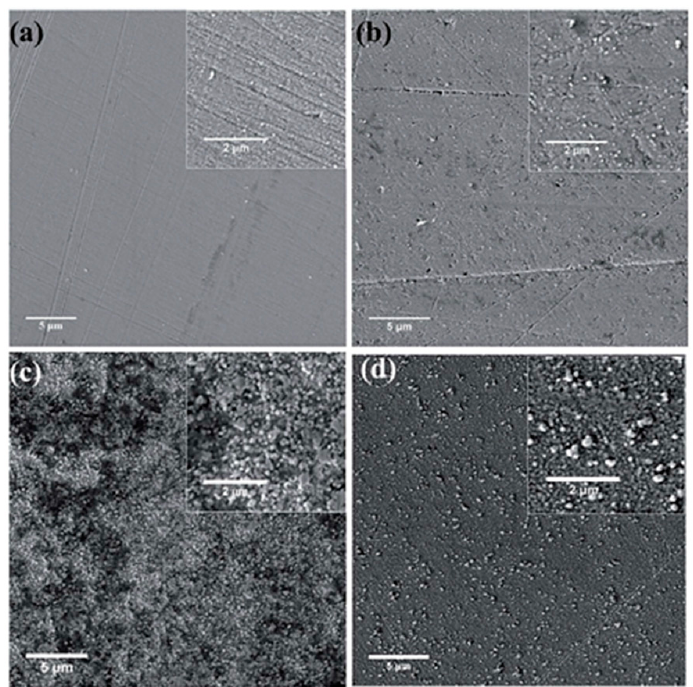
Figure 3. SEM images of nickel coatings formed on copper substrate at 363 K under potentiostatic electrodeposition at various potential (vs. Ag) ( a ) − 0.40, ( b ) − 0.50, ( c ) − 0.60, ( d ) − 0.70. [Reproduction